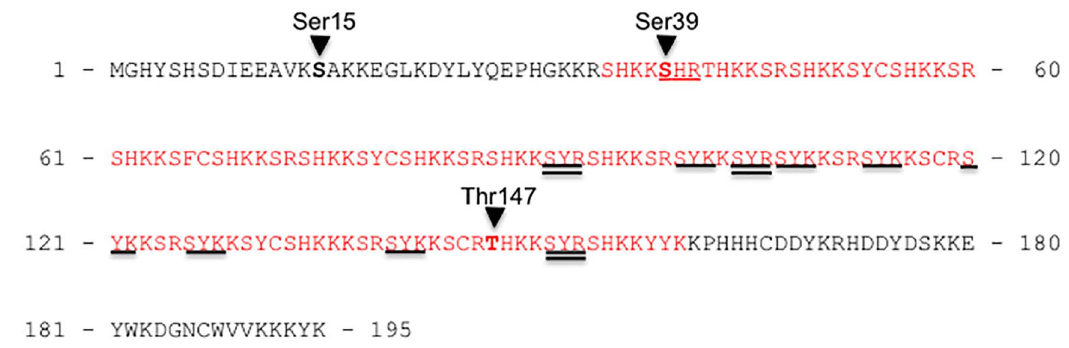
Figure 6. CotG and phosphorylation sites. Results of a mass spectrometry analysis of peptides derived from trypsine digestion of CotG are reported. Unambiguosly identified sites of phosphorylation are indicated. Tripeptides containing a phosphate moiety are underlined; the random coiled tandem repeats region is in red.